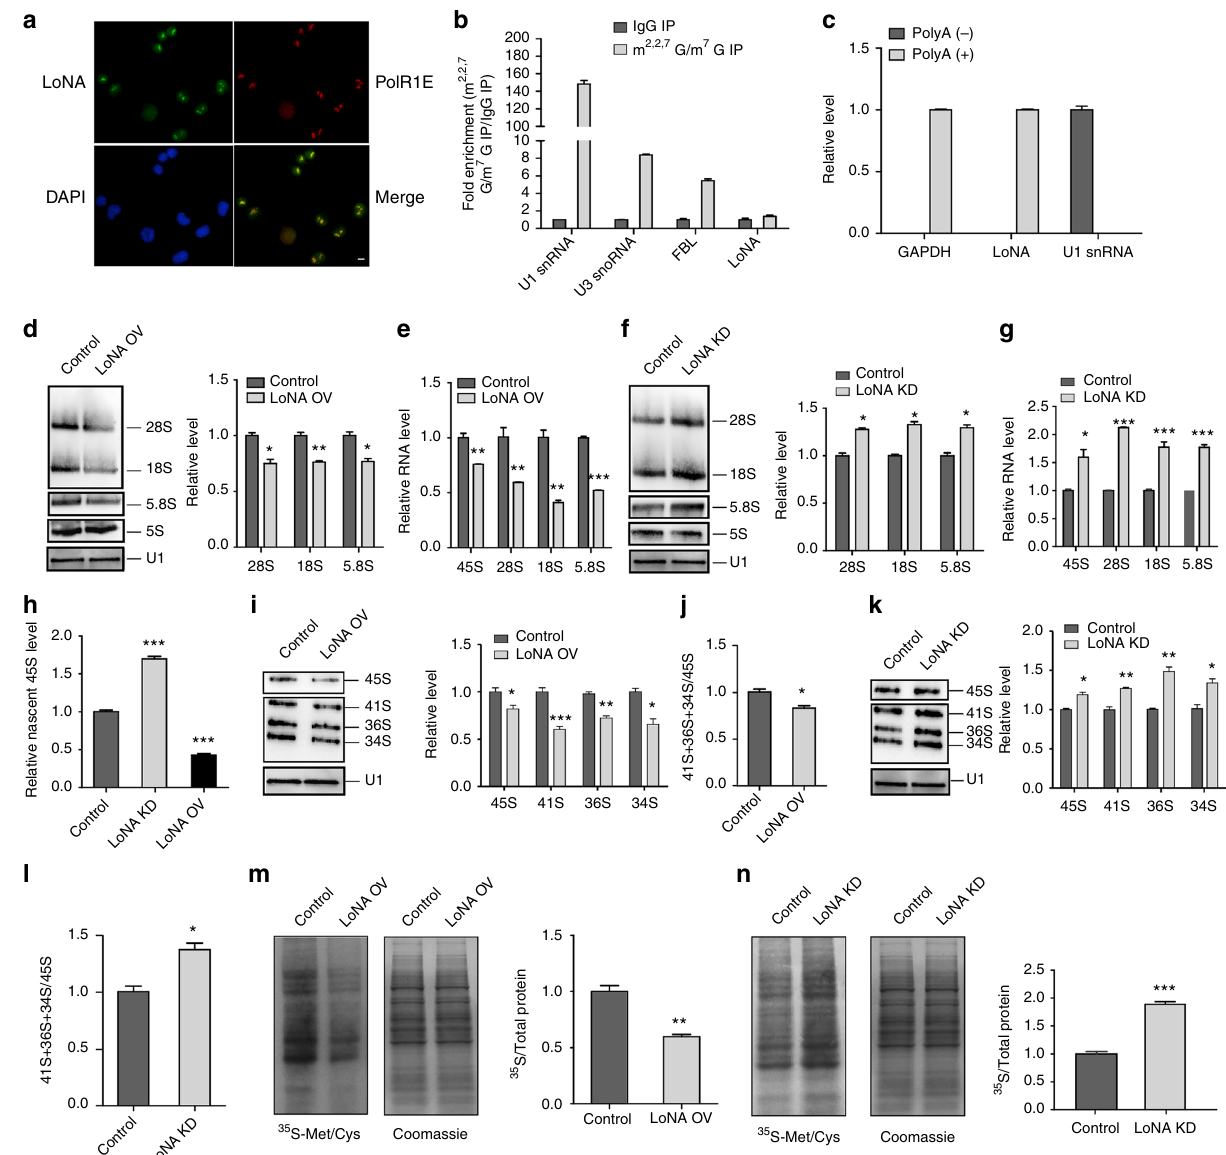
Fig. 2 LoNA coordinates rRNA transcription and protein translation. a Nucleolar localization of LoNA. Representative immuno fl uorescence images of polR1E (red), LoNA RNA FISH (green), and DAPI (blue). Scale bar: 10 µ m. b LoNA lacks m 2,2,7 G and m 7 G cap. IP was performed with total RNAs isolated from N2a cells using anti-m 2,2,7 G/m 7 G antibody or control IgG, followed by qPCR detection. Bar plots represent fold enrichments of immunoprecipitated RNAs by antibody over IgG control. U1 snRNA, U3 snoRNA, and FBL were included as positive controls. c LoNA is polyadenylated. poly (A) + and poly (A) − RNAs were puri fi ed from N2a total RNAs by oligo(dT) beads pulldown, followed by qPCR. Data were presented as relative abundance of a particular RNA in each pool. GAPDH was included as poly (A) + control, U1 snRNA as poly (A) − control. d – g Levels of mature rRNAs (28S, 18S, 5.8S, and 5S) were determined by Northern blot (U1 was used as control), densitometric analysis, and qPCR (data were normalized to U1 snRNA) in LoNA-overexpressed N2a cells (LoNA OV) ( d – e ), or LoNA knockdown N2a cells (LoNA KD) ( f , g ). h Nascent pre-rRNA (45S) levels were determined by nuclear run-on assay. i – l Levels of pre-rRNA (45S) and intermediate rRNAs (41S, 36S, and 34S) were determined in LoNA transfected N2a cells (LoNA OV) by Northern blot (U1 was used as control), densitometric analysis ( i ) and qPCR (45S only) ( e ), as well as in LoNA-de fi cient N2a cells (LoNA KD) by Northern blot (U1 was used as control), densitometric analysis ( k ) and qPCR (45S only) ( g ). j , l Ratio of total intermediate rRNA to the precursor 45S, as determined by densitometric analysis. m , n LoNA administered or de fi cient N2a cells were pulsed with 35 S-Met/Cys, de novo protein synthesis was quanti fi ed as the mean ratio of 35 S incorporation relative to total protein (Coomassie). For this and subsequent fi gures, OV represents overexpression, KD represents knockdown. Sequences of Northern blot probes and qPCR primers are listed in supplementary materials. * P < 0.05; ** P < 0.01; *** P < 0.001 by ANOVA or two-tailed Student ’ s t test, error bars,